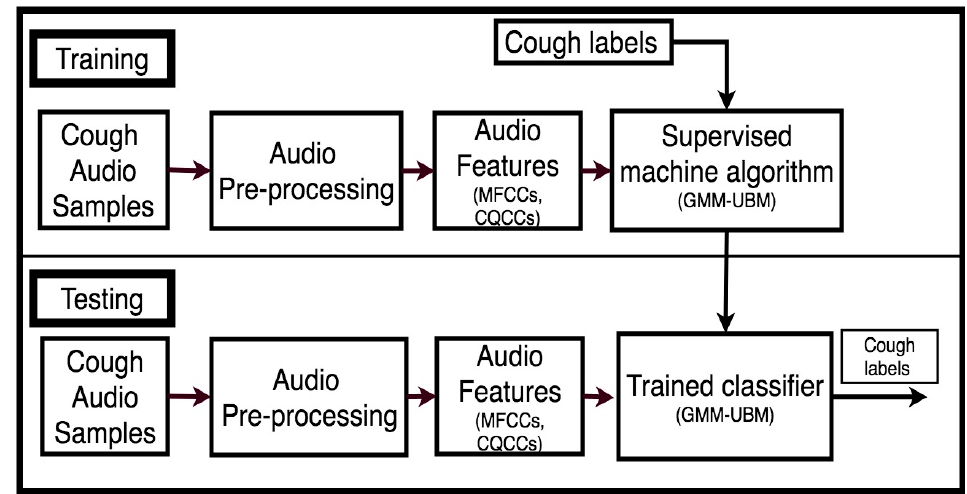
Figure 1. Experimental methodology to train and evaluate the Gaussian Mixture Model (GMM) Figure1. classifier.